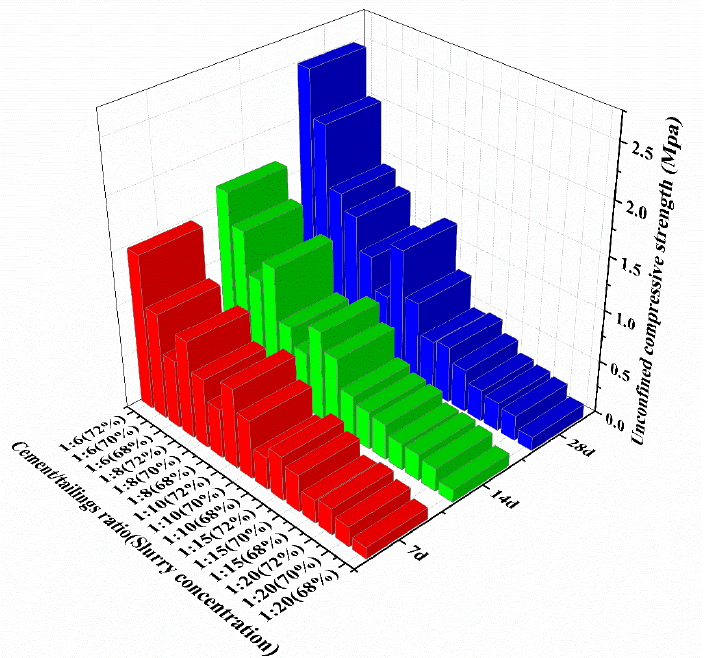
Figure 4. Unconfined compressive strength evolution with different cement/tailing ratios (slurry concentrations).